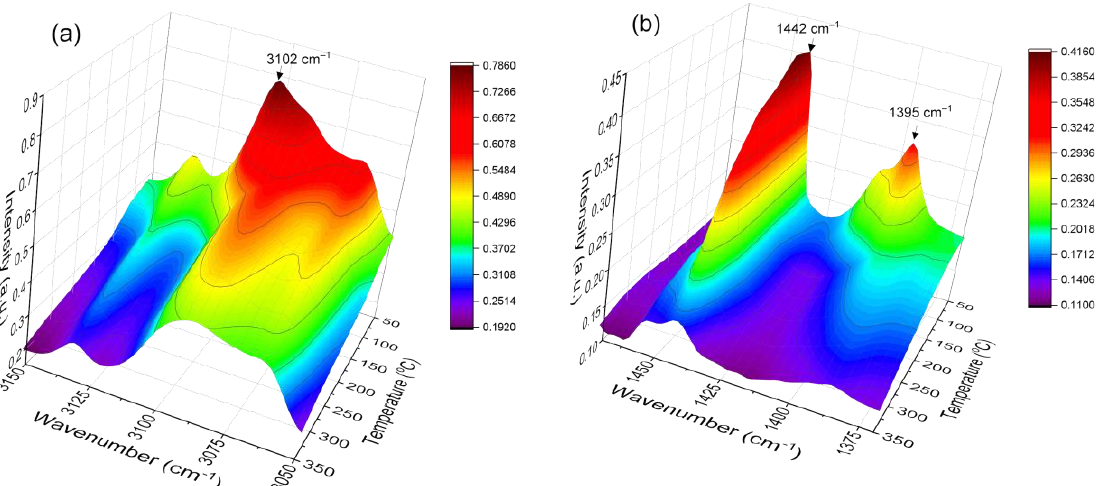
of 3150–3050 cm − 1 ( a ) and 1470–1370 cm − 1 ( b Figure 8. In situ FT-IR spectra of NaCeY S sorbent at different desorption temperatures in the regions of 3150 – 3050 cm −1 ( a ) and 1470 – 1370 cm −1 ( b ).